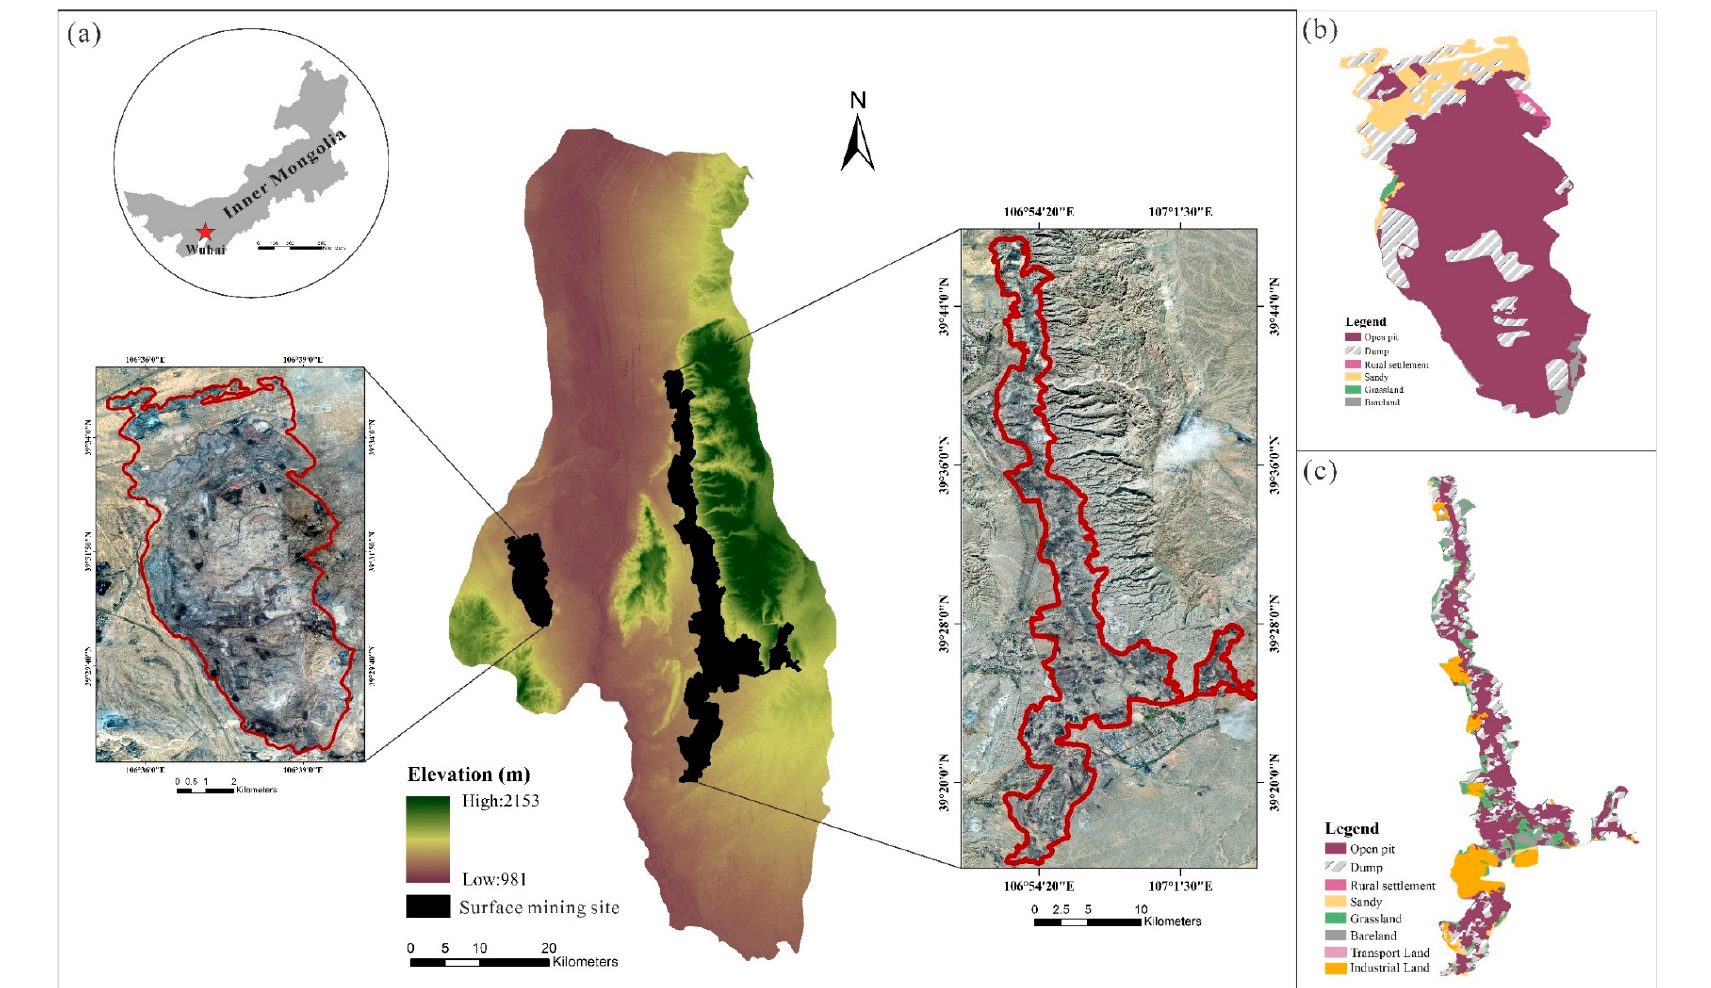
Figure 1. ( a ) Location of the study area in Wuhai and surrounding areas, Inner Mongolia, China; ( b ) land use in the western mine; ( c ) land use in the eastern mine.